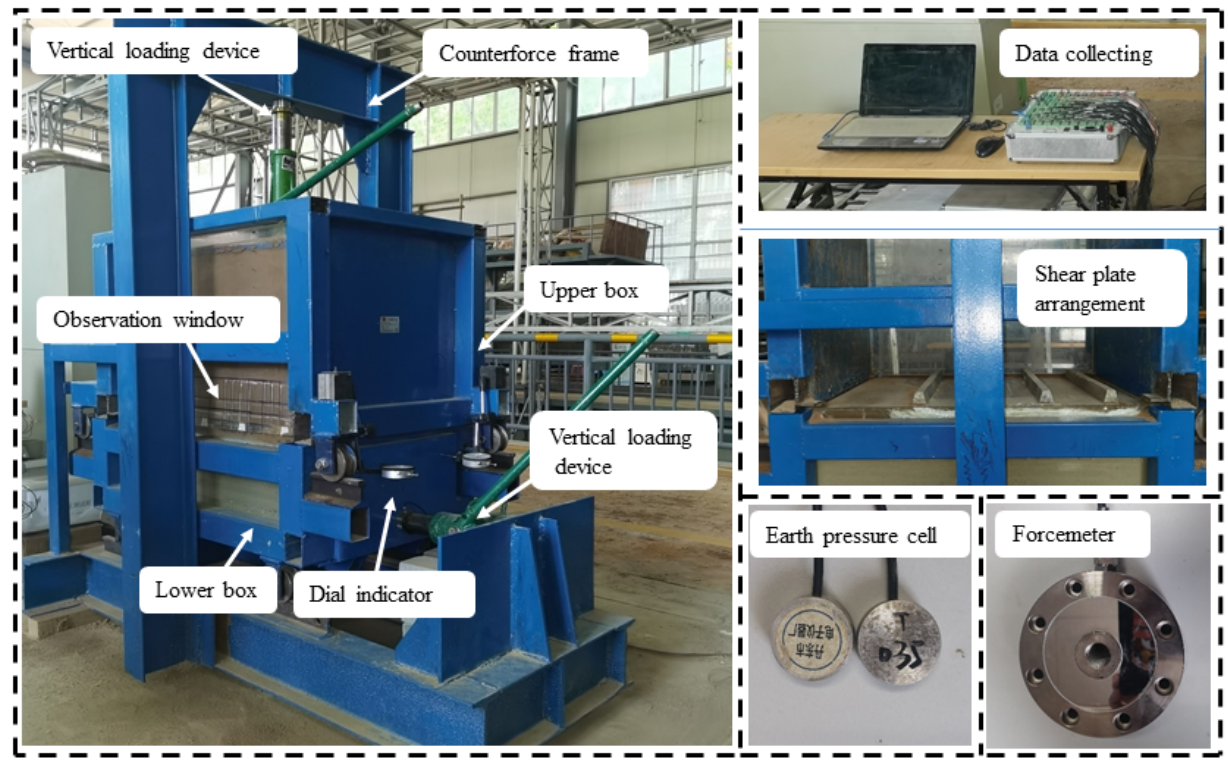
Figure 3. Large ‐ scale direct shear apparatus. Figure 3. Large-scale direct shear